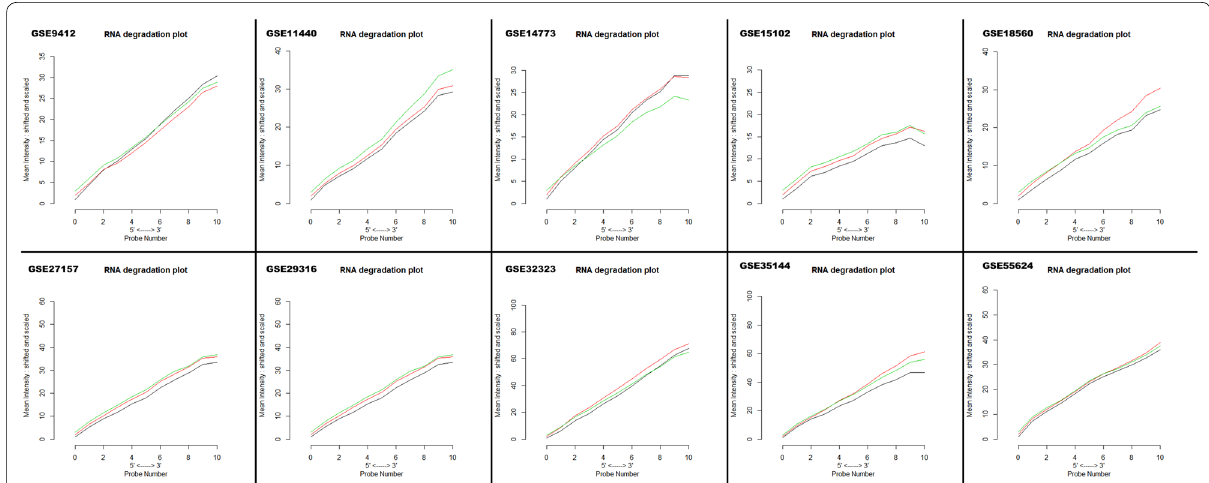
Fig. 2 RNA degradation plot of each dataset produced by plot AffyRNAdeg showing 5 ′ to 3 ′ trend to evaluate the severity of RNA degradation and significance level